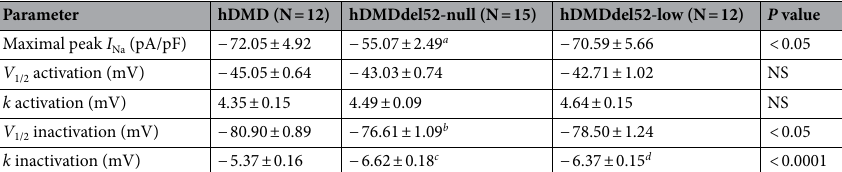
Table 1. Current density and gating characteristics of the sodium current ( I Na ). Half-voltage ( V 1/2 ) and slope factor ( k ) of the (in)activation curves were calculated using a Boltzmann fit. N represents the number of cardiomyocytes measured. Cardiomyocytes were isolated from 3 hDMD, 4 hDMDdel52-null, and 3 hDMDdel52-low mice. NS: no significant differences between groups, a P < 0.05 vs hDMD and hDMDdel52- low, b P < 0.05 vs hDMD, c P < 0.0001 vs hDMD, d P < 0.001 vs hDMD (one-way ANOVA with Tukey’s post-hoc